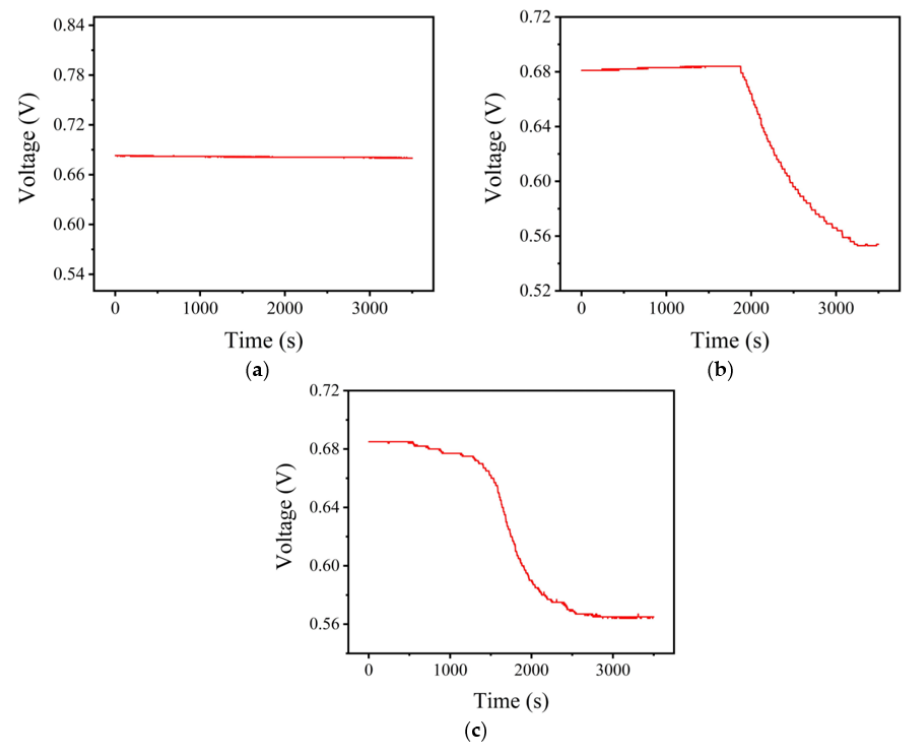
Figure 6. PEMFC voltage evolution at different PEMFC states. ( a ) Normal; ( b ) Flooding; ( c ) Dehydration.